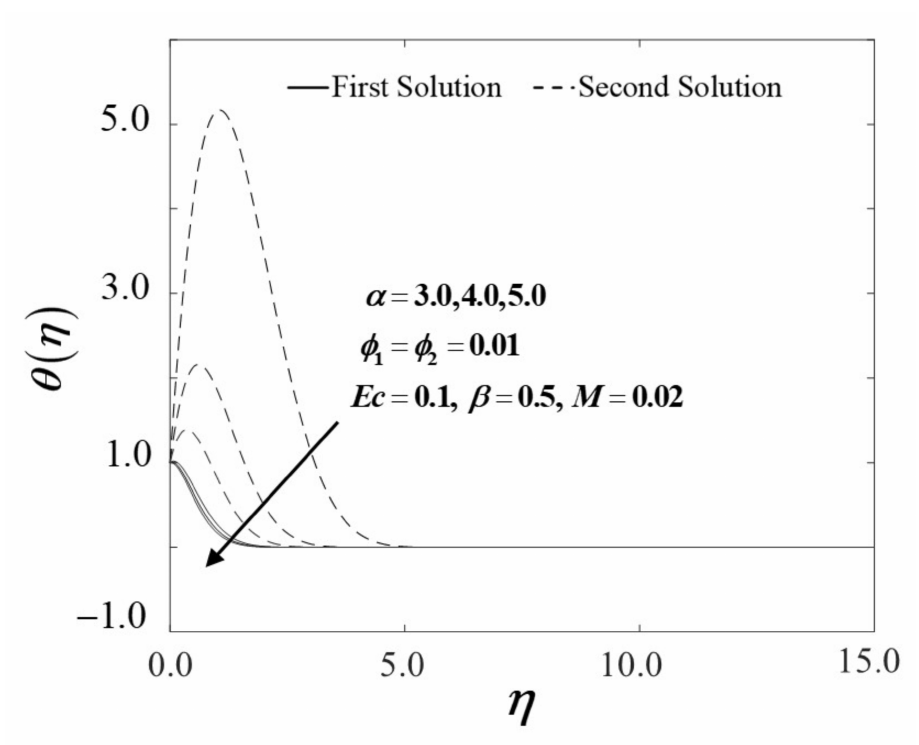
Figure 11. θ ( η ) versus η with specific α